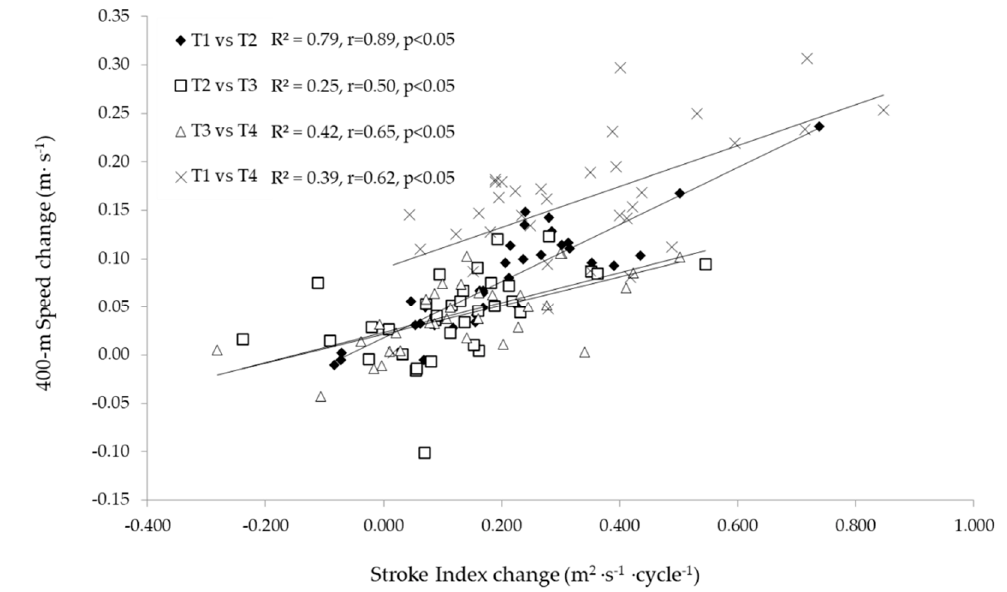
Figure 4. Relationship of stroke index changes and 400 m speed changes between macrocycles. T1: beginning of the general preparation period of the first macrocycle; T2, T3, and T4: end of the competitive period of the first, second, and third macrocycles.